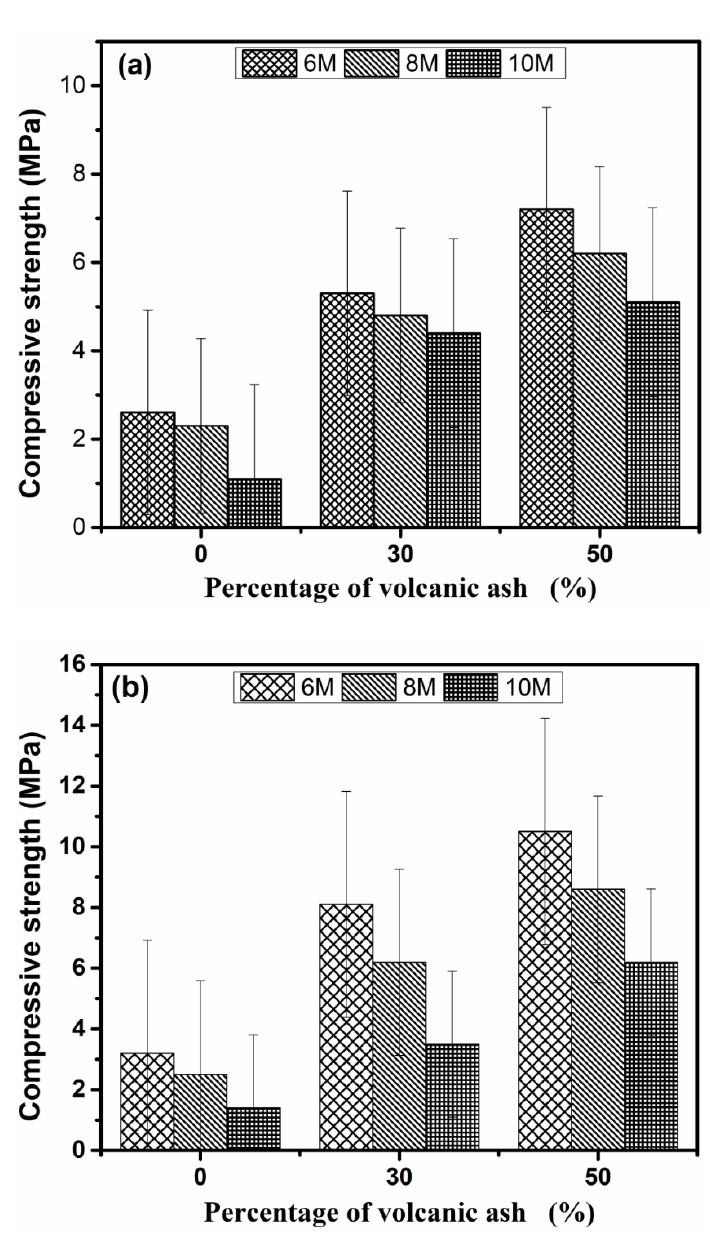
Figure 7. Compressive strength of Geopolymer samples cured at 14 days ( a ) and 28 days ( b ).